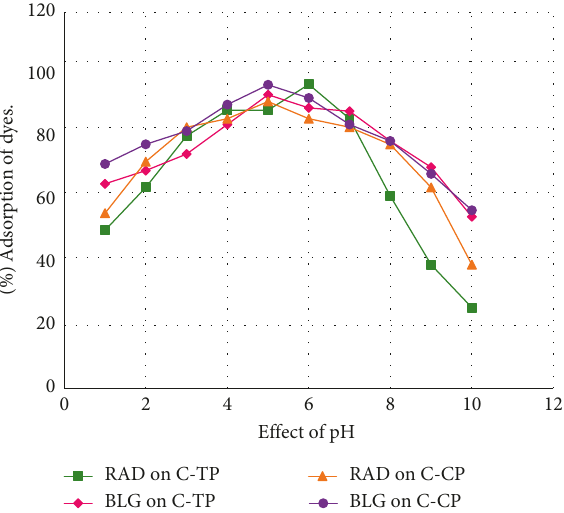
Figure 13: Influence of pH on adsorption